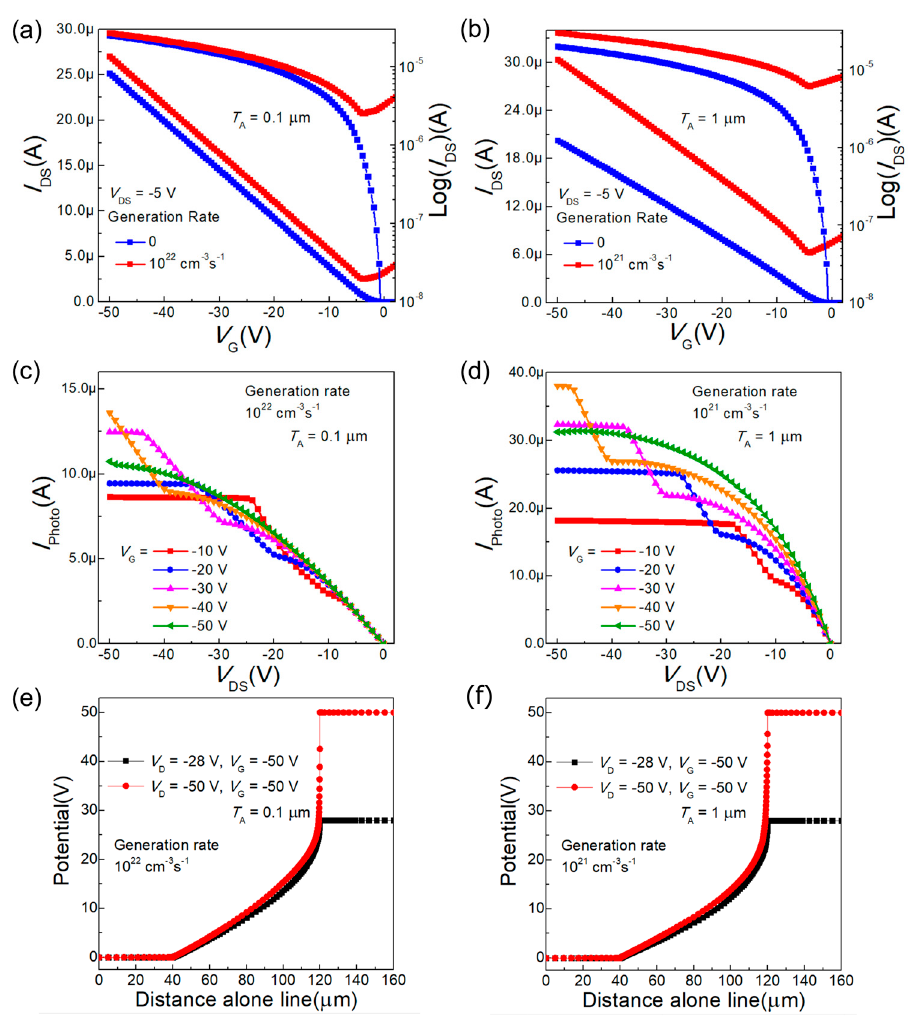
Figure 7. Simulated transfer curve characteristics ( a , b ), photocurrent characteristics ( c , d ) and cross- section surface potential ( e , f ). ( a , c , e ) are the results of device with 100 nm channel and photogener- ation rate of 1 × 10 22 cm − 3 s − 1 ; ( b , d , f ) are the results of device with 1 μ m channel and photogeneration rate of 1 × 10 21 cm − 3 s − 1 .